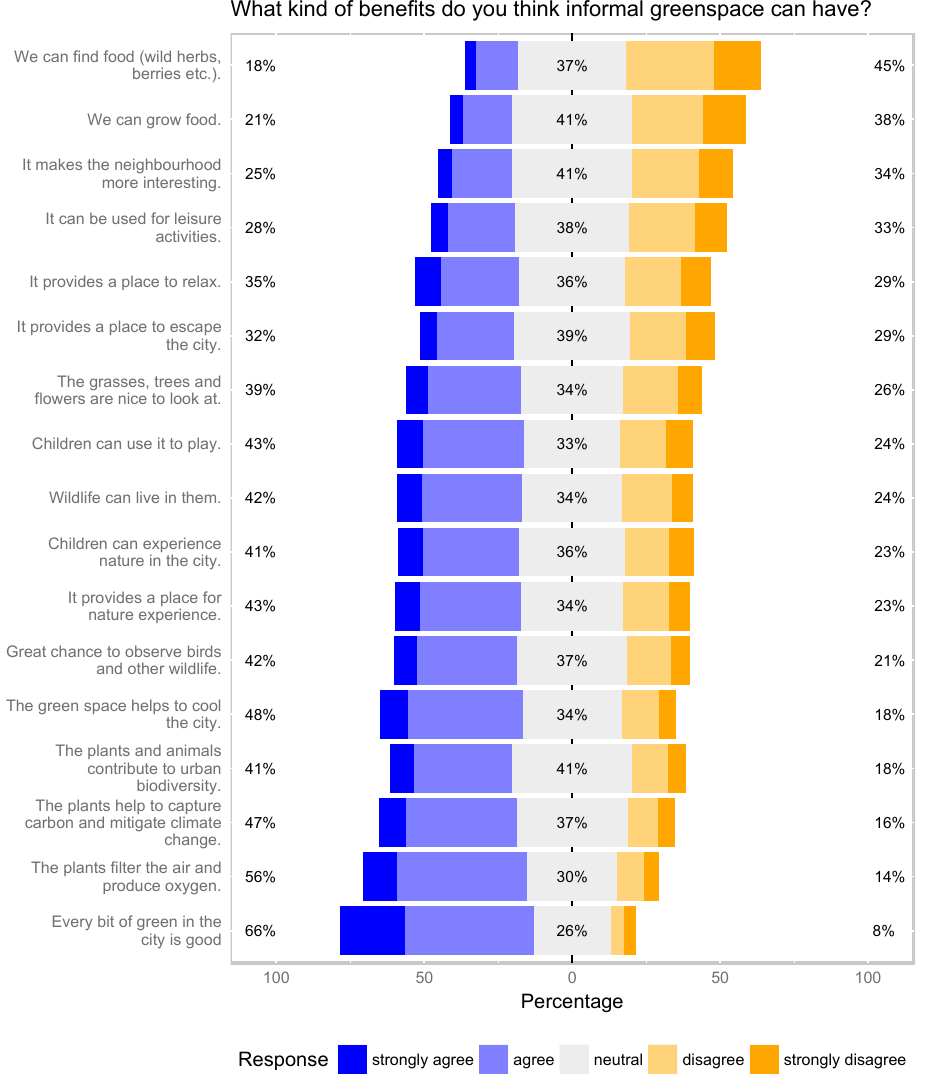
Figure 5. Respondents’ level of agreement to potential IGS benefits.